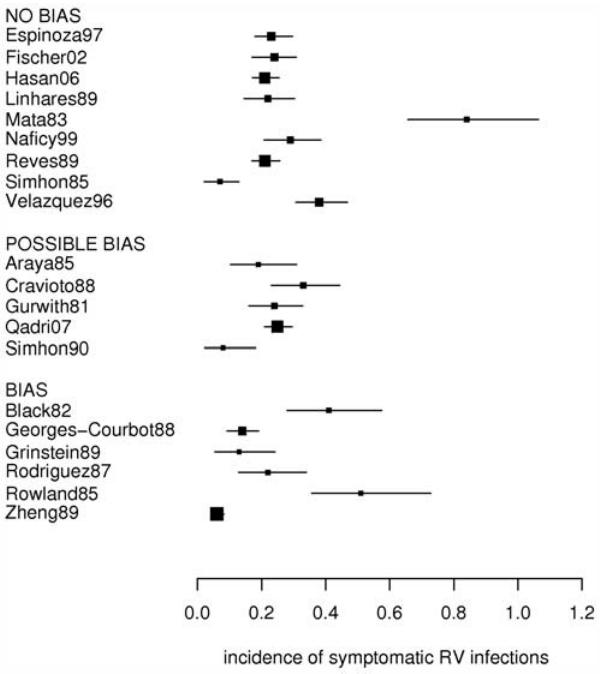
Figure 2. Incidence of symptomatic RV infections in children below age 2 for the 20 eligible studies. Forest plot showing incidence (number of symptomatic RV infections per personyear of observation; boxes) and 95% credible intervals (horizontal lines), obtained from studies which were evaluated to be at respectively no high risk of bias (‘no bias’), possible high risk of bias (‘possible bias’), and high risk of bias (‘bias’). The size of each box is proportionate to the person-years of observation from each study.